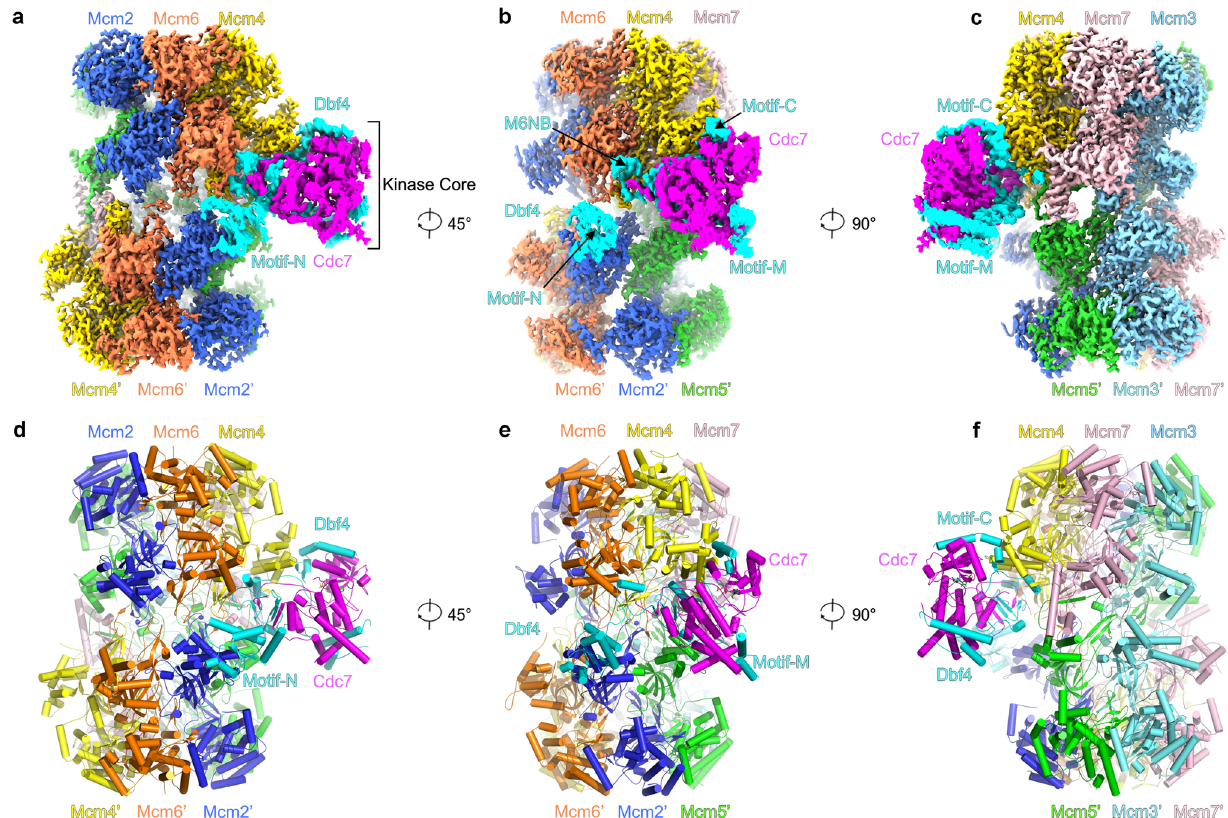
Fig. 1 Overall structure of MCM double hexamer bound with DDK. a – c Side views of the segmented cryo-EM density map of the DDK-DH (State I) displayed with indicated rotations along the cylinder axis. d – f Same as ( a – c ) respectively but shown with the cylindrical atomic model. MCM subunits, Dbf4, and Cdc7 subunits are color-coded and labeled as indicated. The positions of the motifs N, M, and C of Dbf4 and the kinase core of DDK are also labeled and